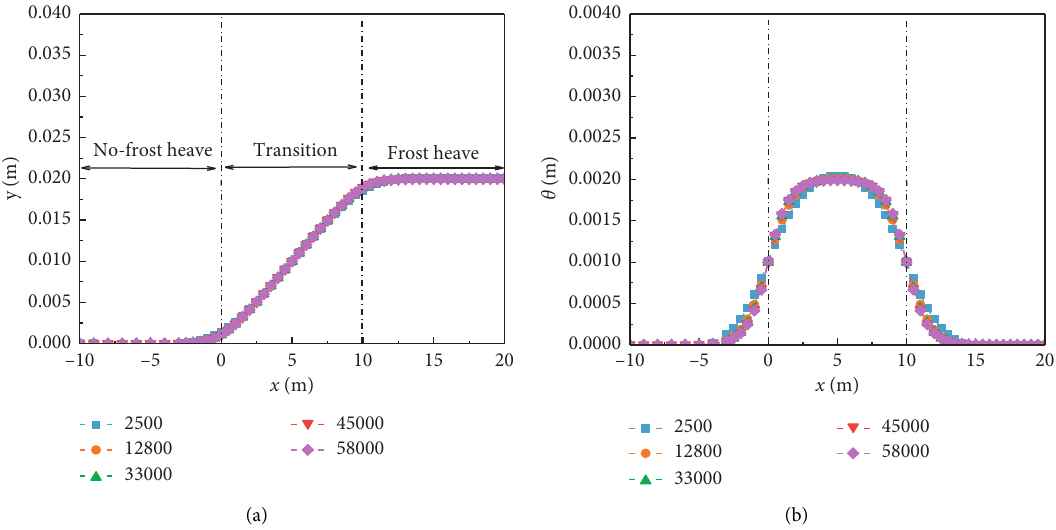
Figure 3: Effects of different foundation coefficients on the distribution of lining deflection (a) and rotation angle (b).